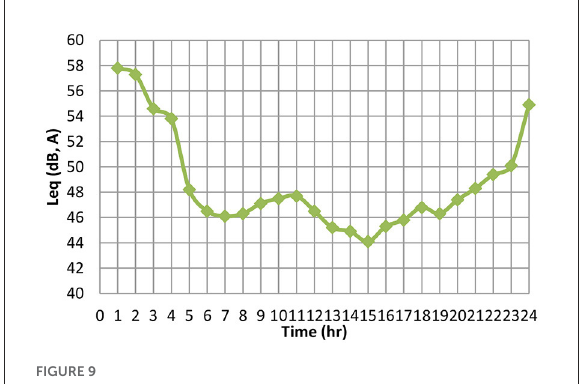
FIGURE9 Variation of hourly average noise level at industrial area.